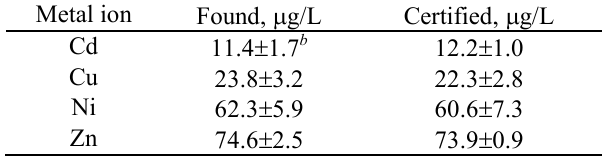
Table 3. Analysis of standard reference material (NIST 1643c, water) a